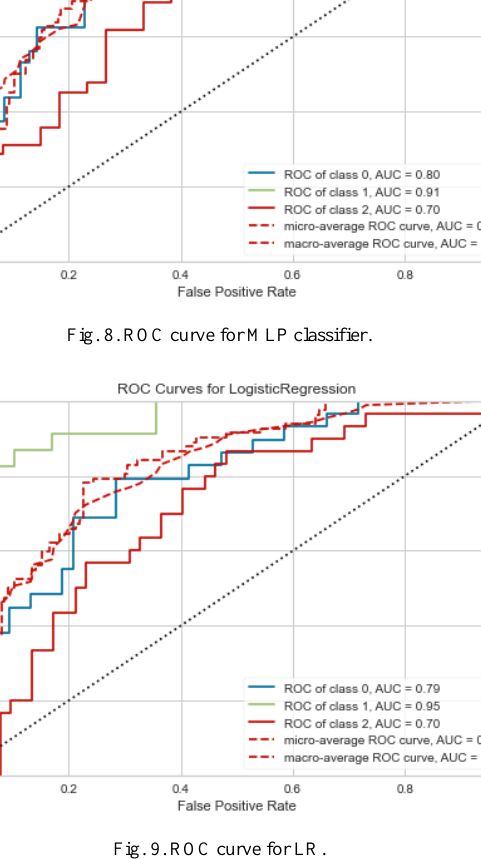
Fig. 12. Classification report for